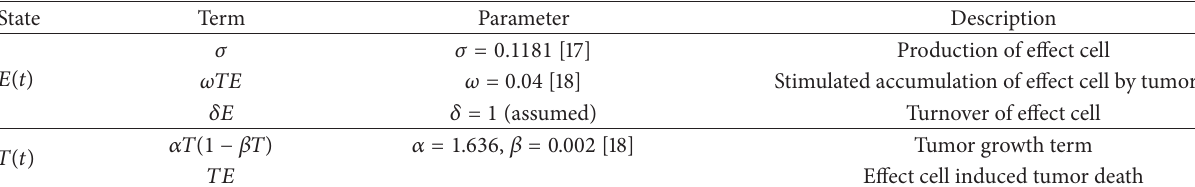
Table 1: Equations and parameter descriptions.